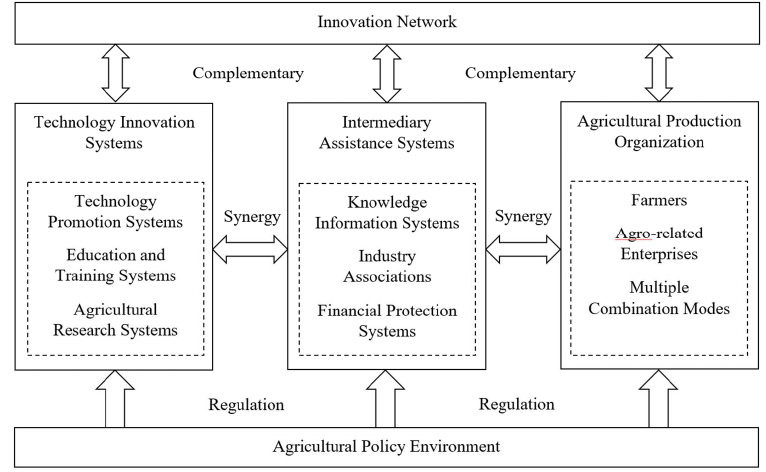
Figure 1. Structure of the functions and relationships of the various actors in the agricultural innovation system.